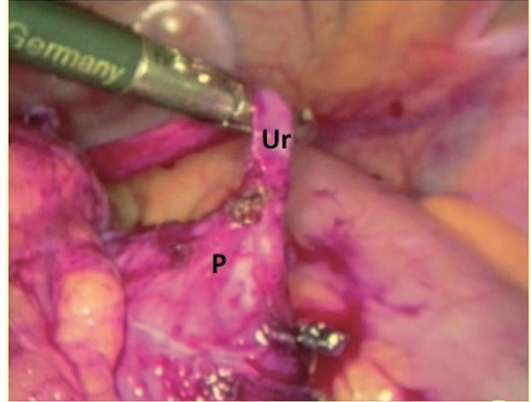
Figure 3 - Transperitoneal aspect of a Pelvic Kidney in a one-year-old boy.